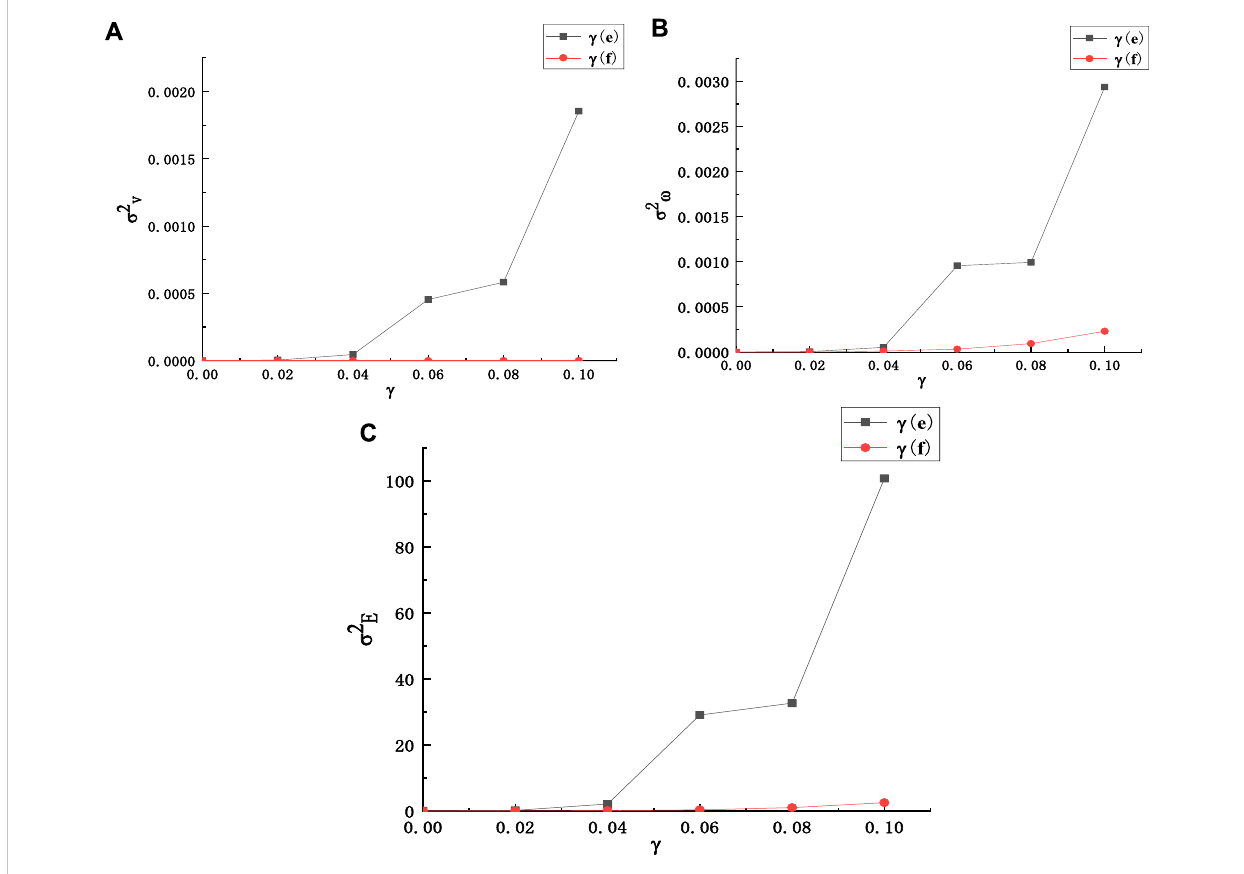
FIGURE 14 Varianceofkinematicscharacteristicsofrockfall, (A) Variationcurveofvelocityvarianceofrockfall, (B) Variationcurveofangularvelocityvarianceof rockfall, (C) Variance curve of rockfall energy.